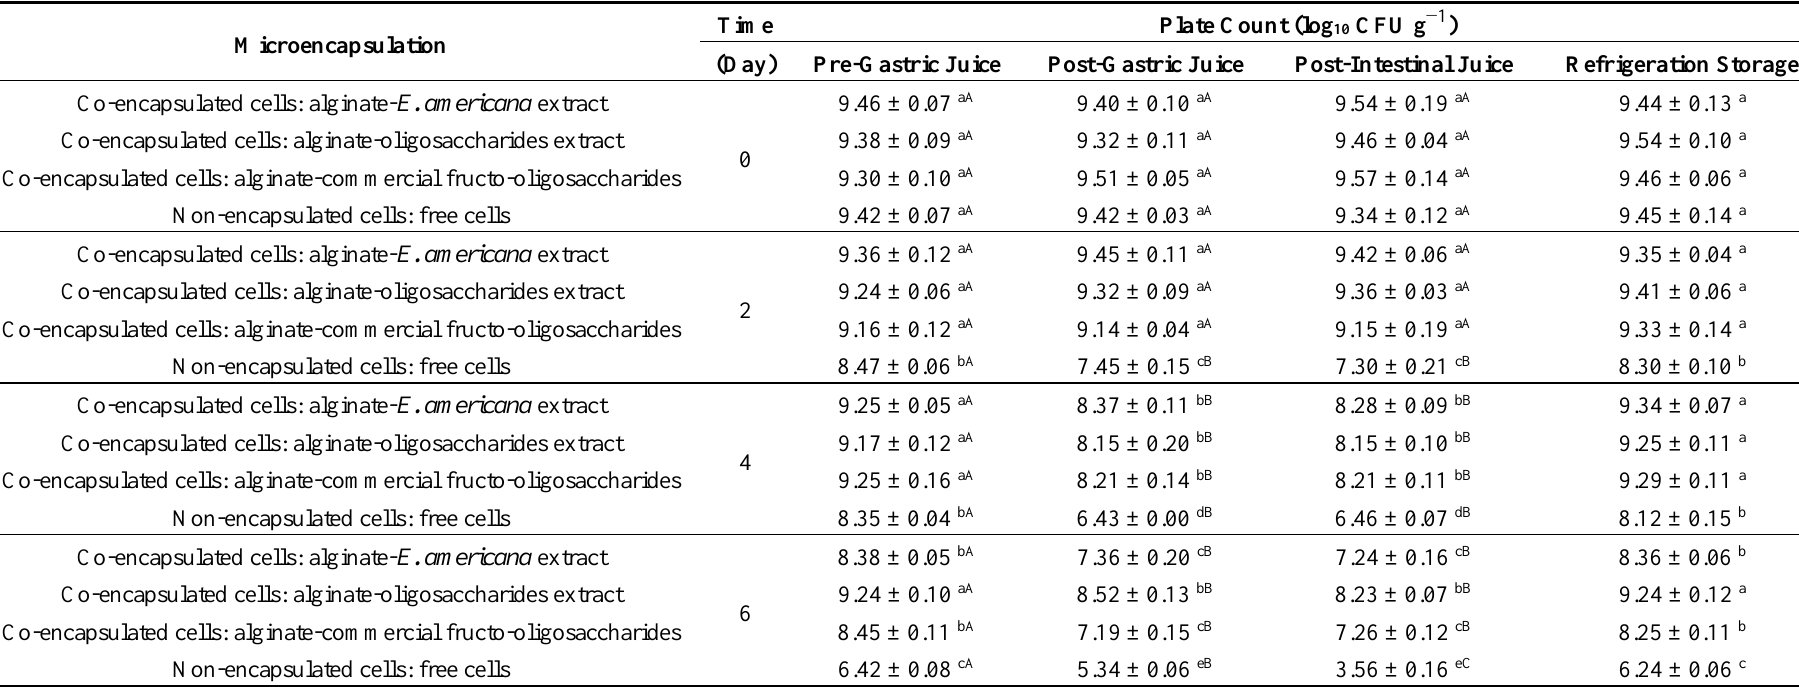
Table 1. Survival of microencapsulated Bifidobacterium longum with Eleutherine americana in fresh milk tofu during sequential incubation in simulated human gastric and intestinal juices and refrigeration